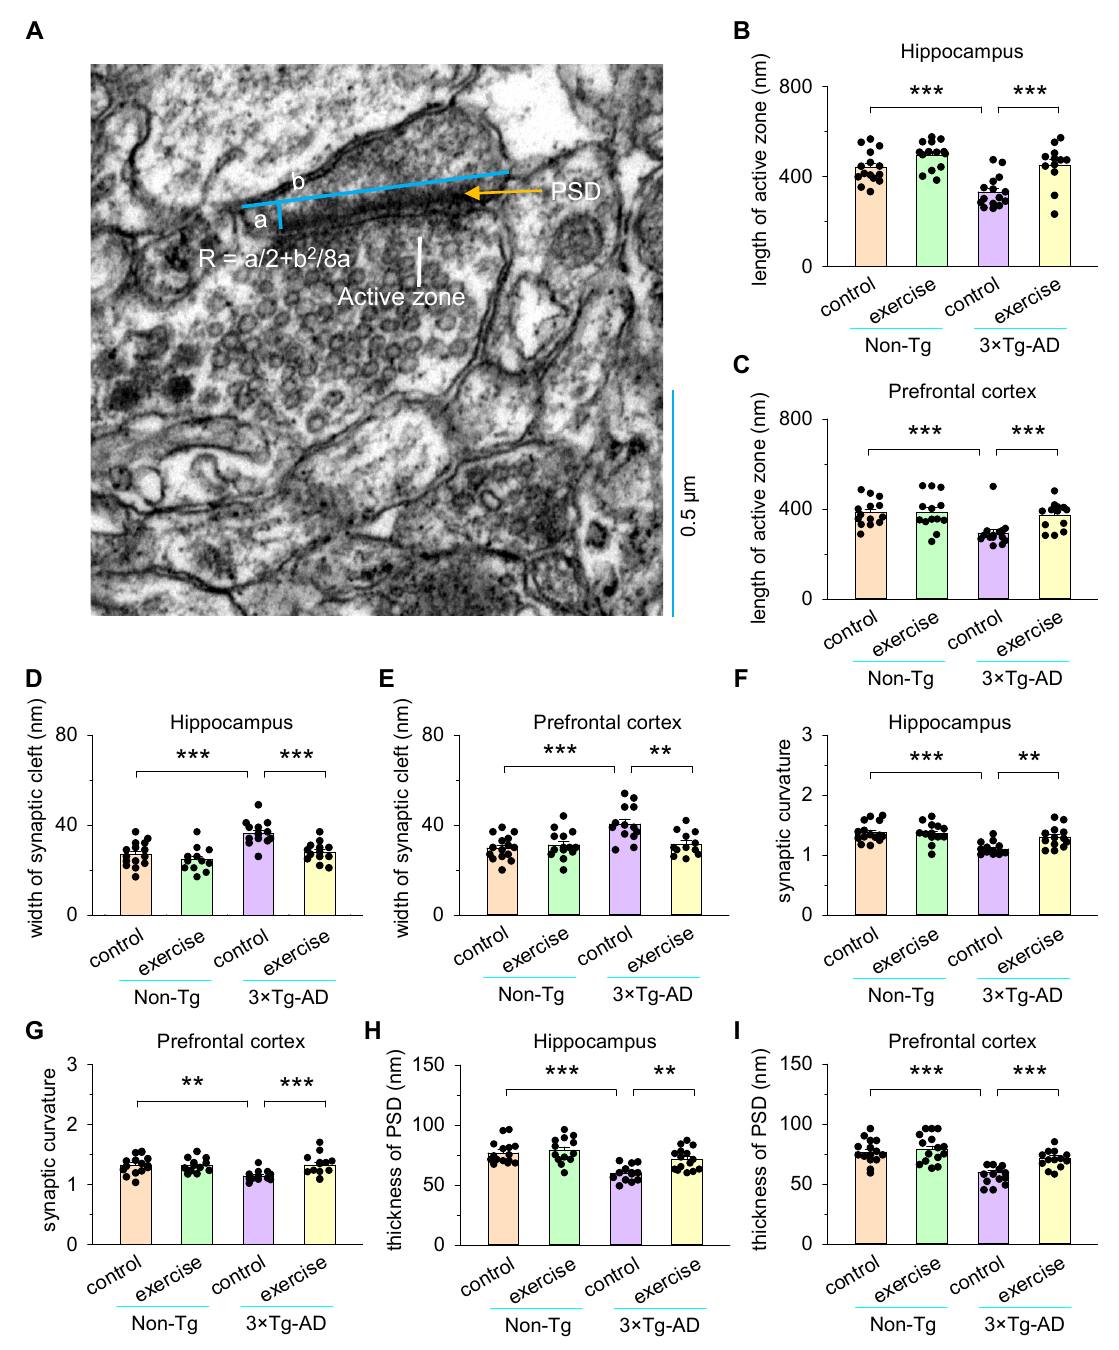
Figure 3. Treadmill exercise improves synaptic structural parameters of the hippocampus and pre- frontal cortex in 3 × Tg-AD mice. ( A ) A representative measurement of synaptic structural parameters. The formula R = a/2 + b 2 /8a, where b is the line joining the two ends of the postsynaptic thickening and a is the perpendicular distance from the postsynaptic membrane to b, was used to determine synaptic curvature. ( B , C ) The length of the synaptic active zone of hippocampus ( B ) and prefrontal cortex ( C ) was significantly decreased in the 3 × Tg-AD control group compared to the non-Tg control group (*** p < 0.001, n = 12–15 synapses), and this decrease was blocked by treadmill exercise pretreat- ment both in the hippocampus and prefrontal cortex (*** p < 0.001, n = 12–15). ( D , E ) The width of the synaptic cleft of the hippocampus ( D ) and prefrontal cortex ( E ) was significantly increased